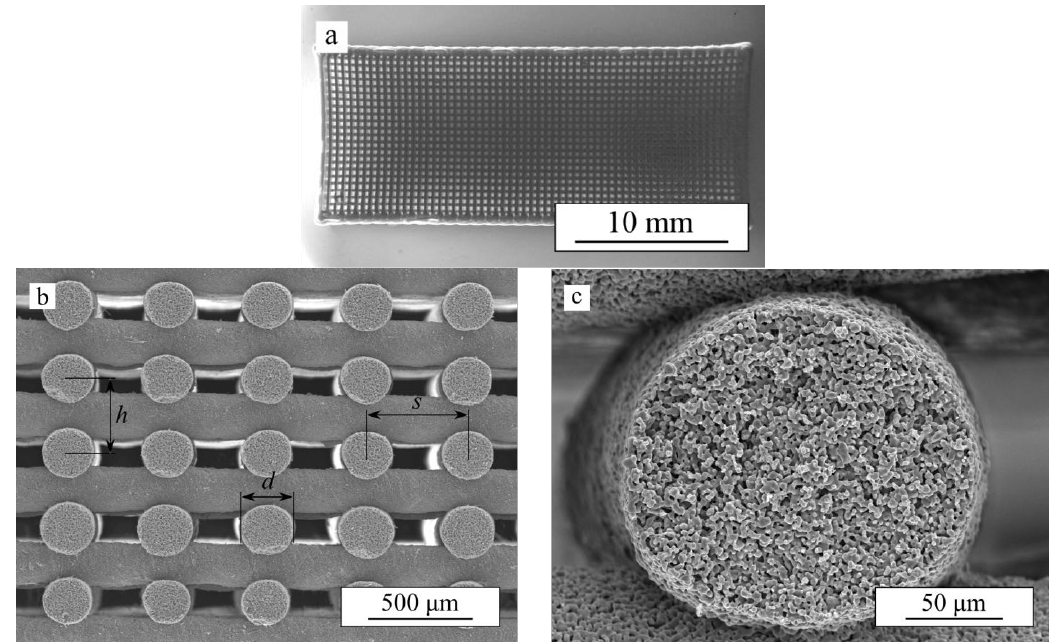
Figure 1. As-received β-TCP scaffolds: ( a ) printing-plane optical image; ( b , c ) SEM micrographs of transversal